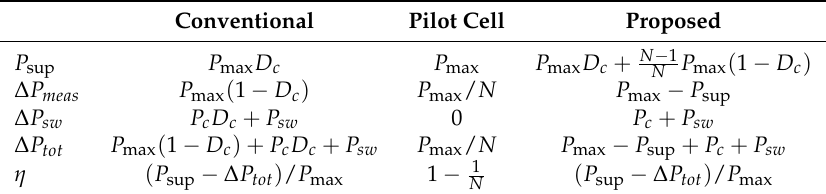
Table 1. Comparison between conventional FOCV, pilot cell FOCV, and proposed semi-pilot cell FOCV